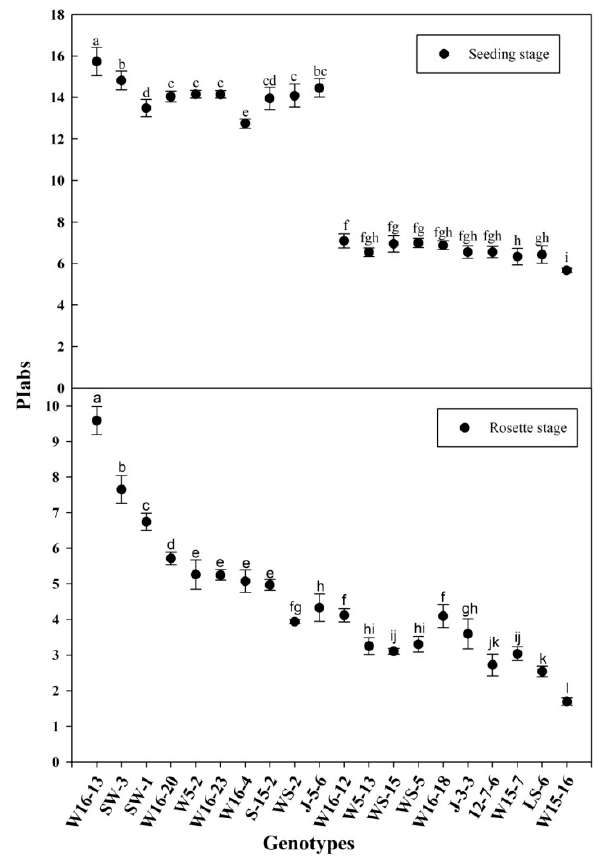
Figure 1. PIabs (seeding stage and rosette stage) of the selected genotypes. Error bars represent the SE ( n = 3). Values with the same letter are not significantly different at the p < 0.05.